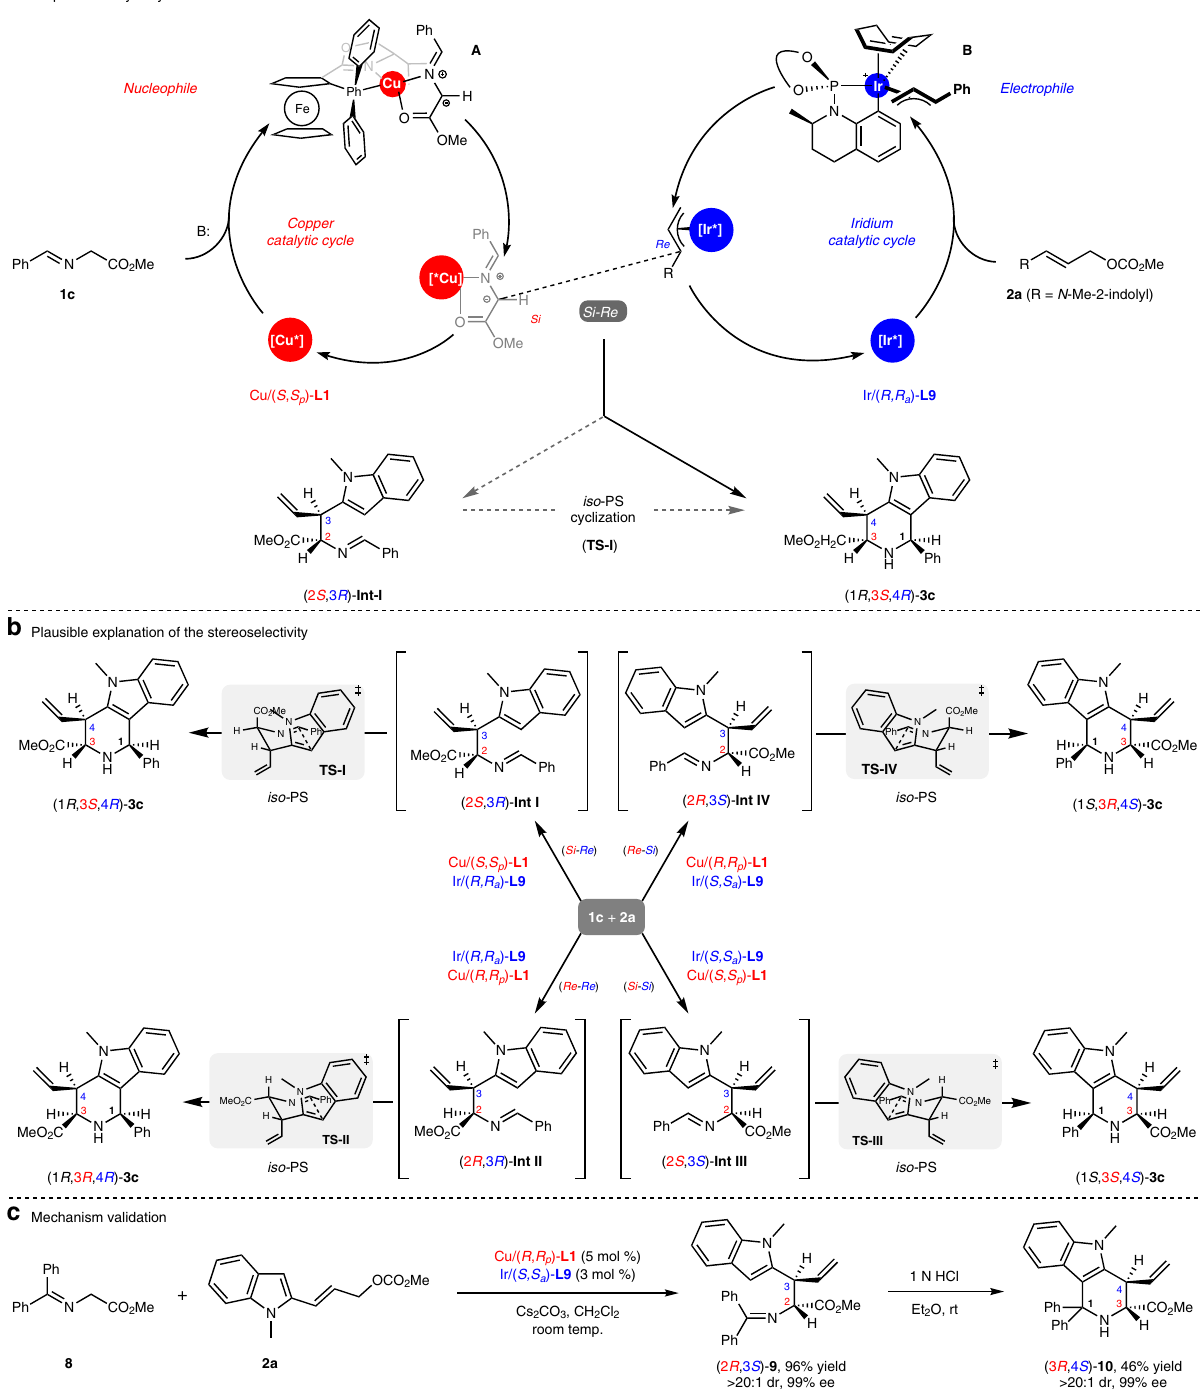
Fig. 4 Proposed mechanism with experimental validation and rationalization of the stereoselectivity. a Proposed catalytic cycle. b Plausible explanation of the stereoselectivity. c Mechanism